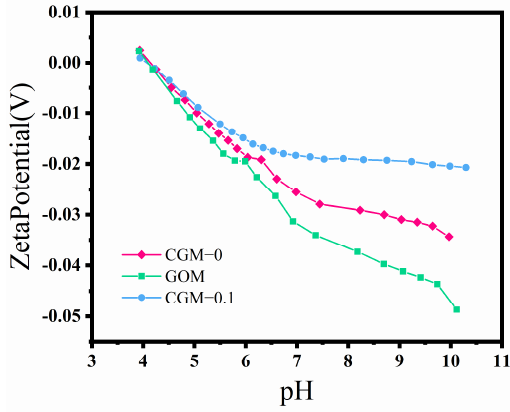
Figure 7. Zeta potential of CGM − 0, GOM and CGM − 0.1.